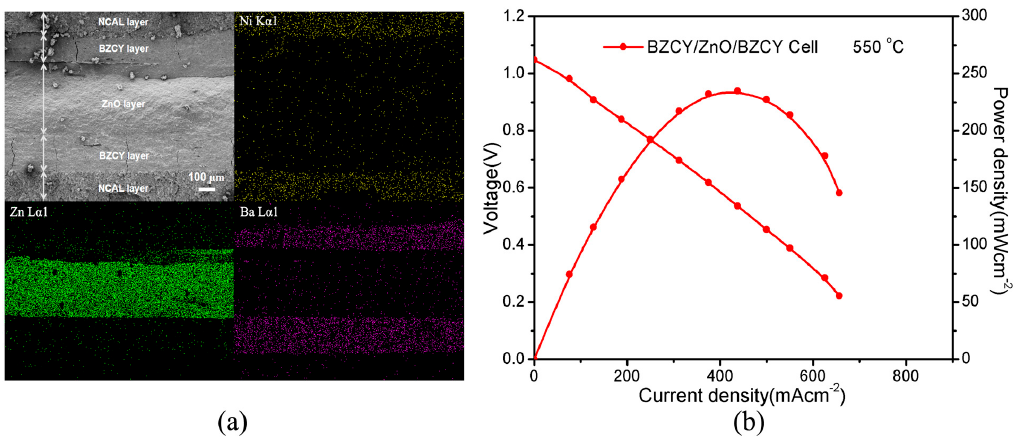
Figure 6. ( a ) A cross-sectional SEM image of the prepared NCAL/BZCY/ZnO/BZCY/NCAL fuel cell after operation and corresponding elemental mapping results for Ni, Zn and Ba; ( b ) Electrochemical performance of the NCAL/BZCY/ZnO/BZCY/NCAL fuel cells tested at 550 °C.